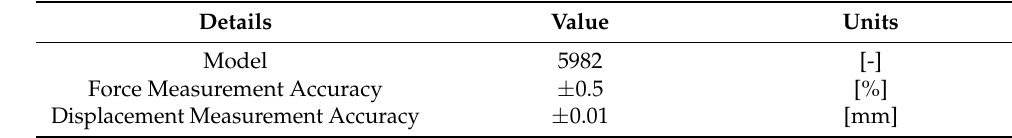
Table 6. The main information about the instrument and